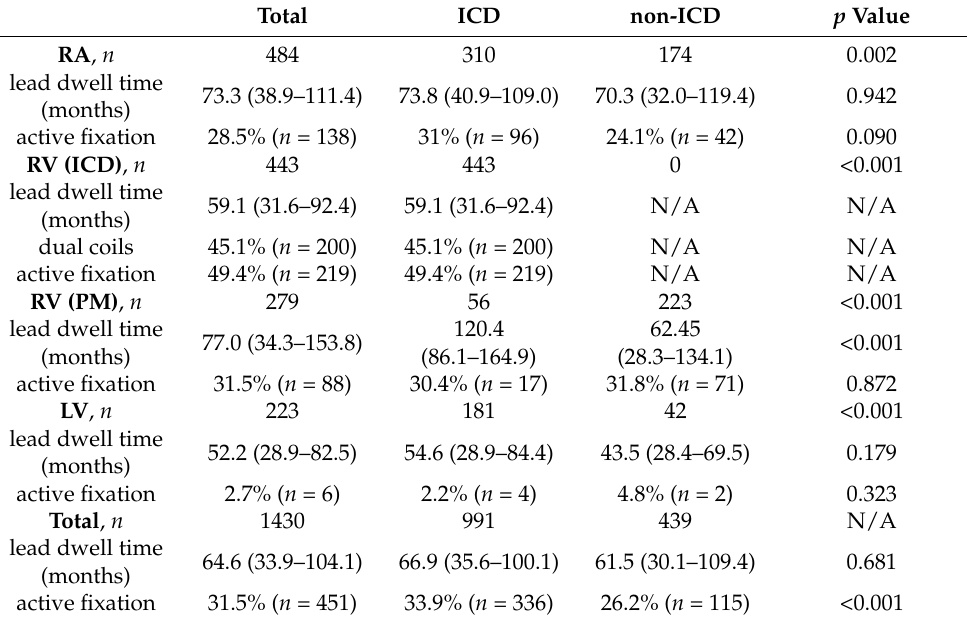
Table 2. Lead details. RA: right atrium; RV: right ventricle; ICD: implantable cardioverter-defibrillator; LV: left